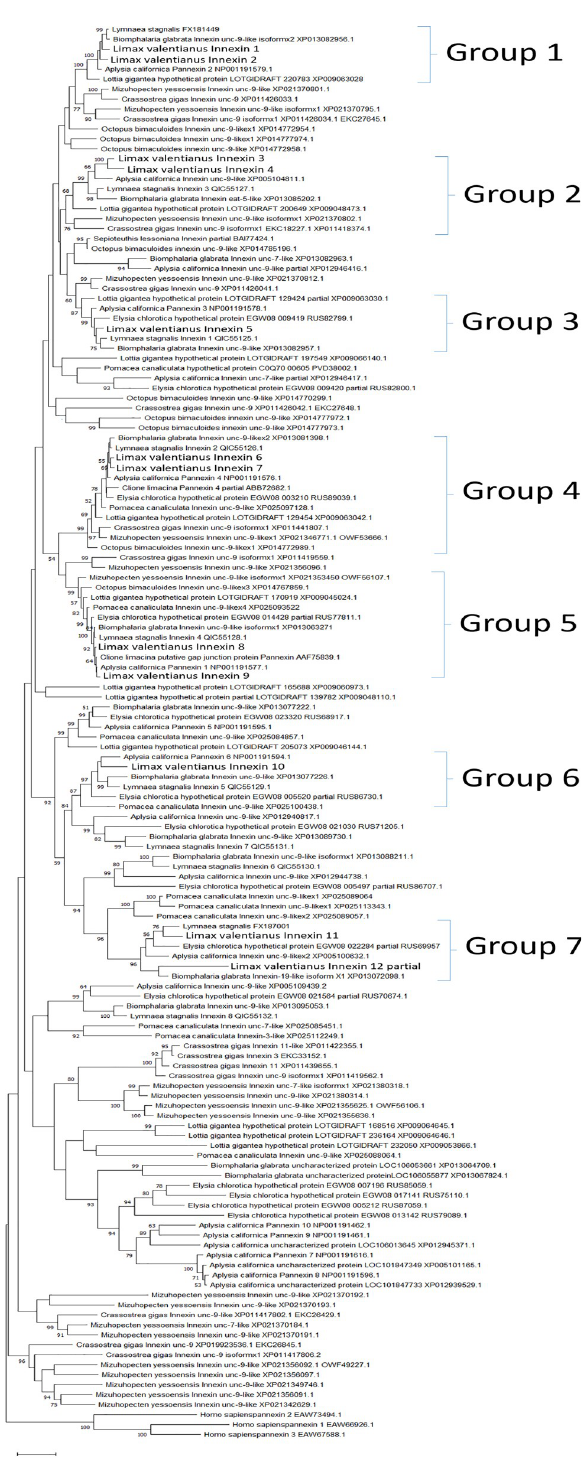
Fig 2. Phylogenetic tree of molluscan innexins. Phylogenetic analysis of molluscan innexins was performed using the maximum likelihood method with Homo sapiens pannexins as the outgroup. The percentage of replicate trees in which the associated taxa clustered together in the bootstrap test (2000 replicates) is shown next to the branches (only values greater than 50 are displayed). Sequence accession numbers are indicated next to species names. The names of Limax innexin homologs are in bold